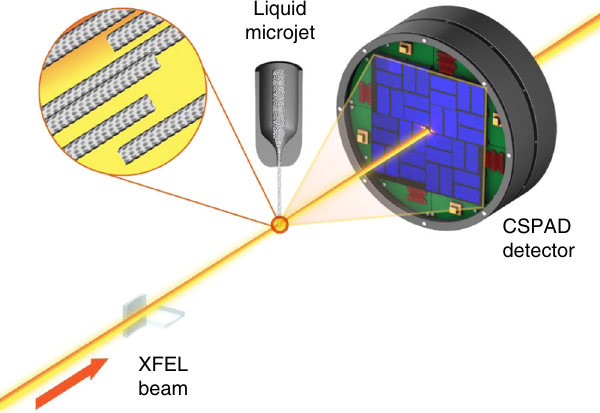
Fig. 1 Schematic illustration of the experimental setup. Samples of pre- formed microtubules were injected across a focused X-ray free electron laser (XFEL) beam. Diffraction data were recorded on a CSPAD X-ray detector which was read out at 120 Hz, which matched the incoming repetition rate of the XFEL. Under the experimental conditions approximately twenty microtubules were intercepted by the X-ray beam as